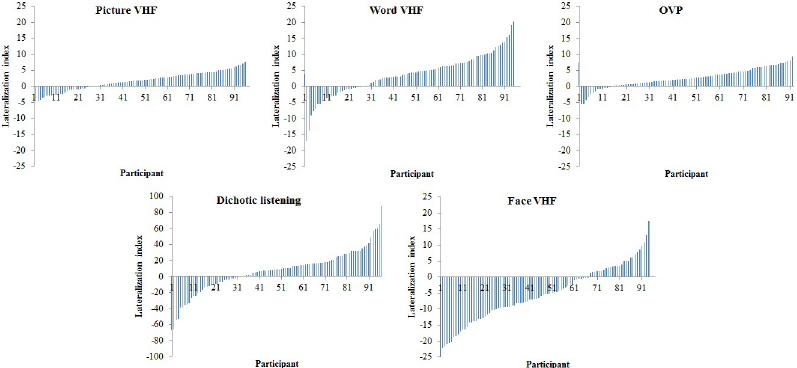
Fig 1. Reaction time lateralization indices for the laterality tasks. Reaction time lateralization index (LI) distributions for the picture visual half field (VHF), word VHF, Optimal Viewing Position (OVP), dichotic listening and face VHF tasks. LIs are sorted from most negative to most positive scores per task. Note that only the dichotic listening chart has a deviating scale on the y-axis to improve visibility because LIs were based on left/right ear matches and not reaction